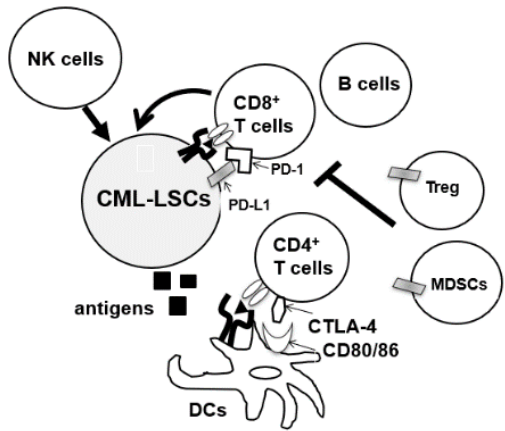
Figure 2. CML-LSCs and immune cells in the tumor microenvironment. NK cells, natural killer cells, MDSCs, myeloid-derived suppressor cells; DCs, dendritic cells, CTLA4, cytotoxic T-lymphocyte- associated protein 4.